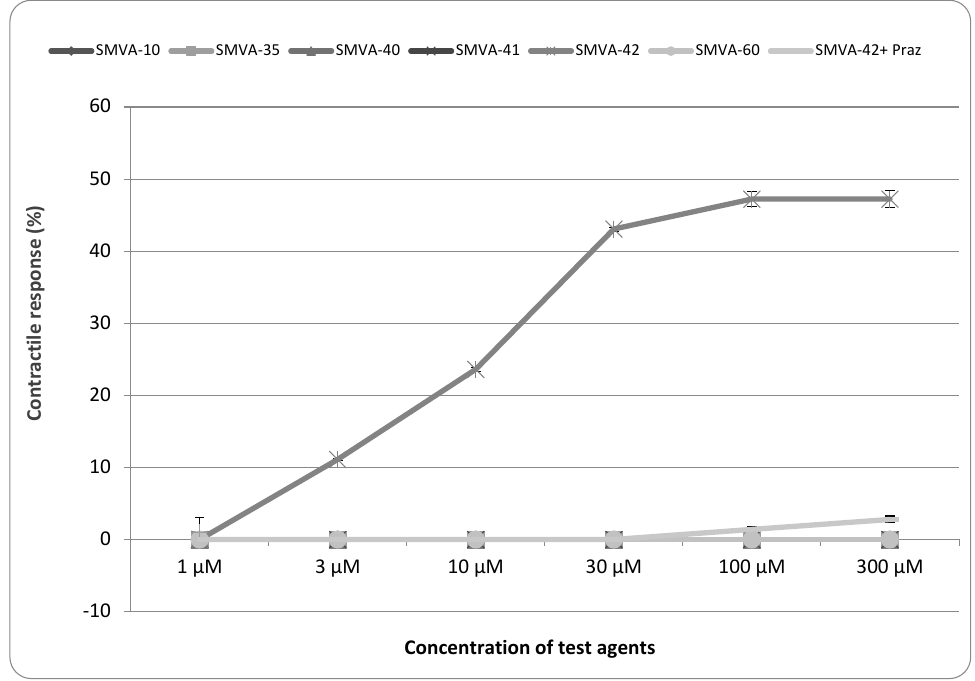
Figure 3. Effects of new synthetic derivatives of thiazole acetic acid on the contractile response (%) in isolated blood vessels and in the presence of Praz. Values are represented as mean ± SEM.